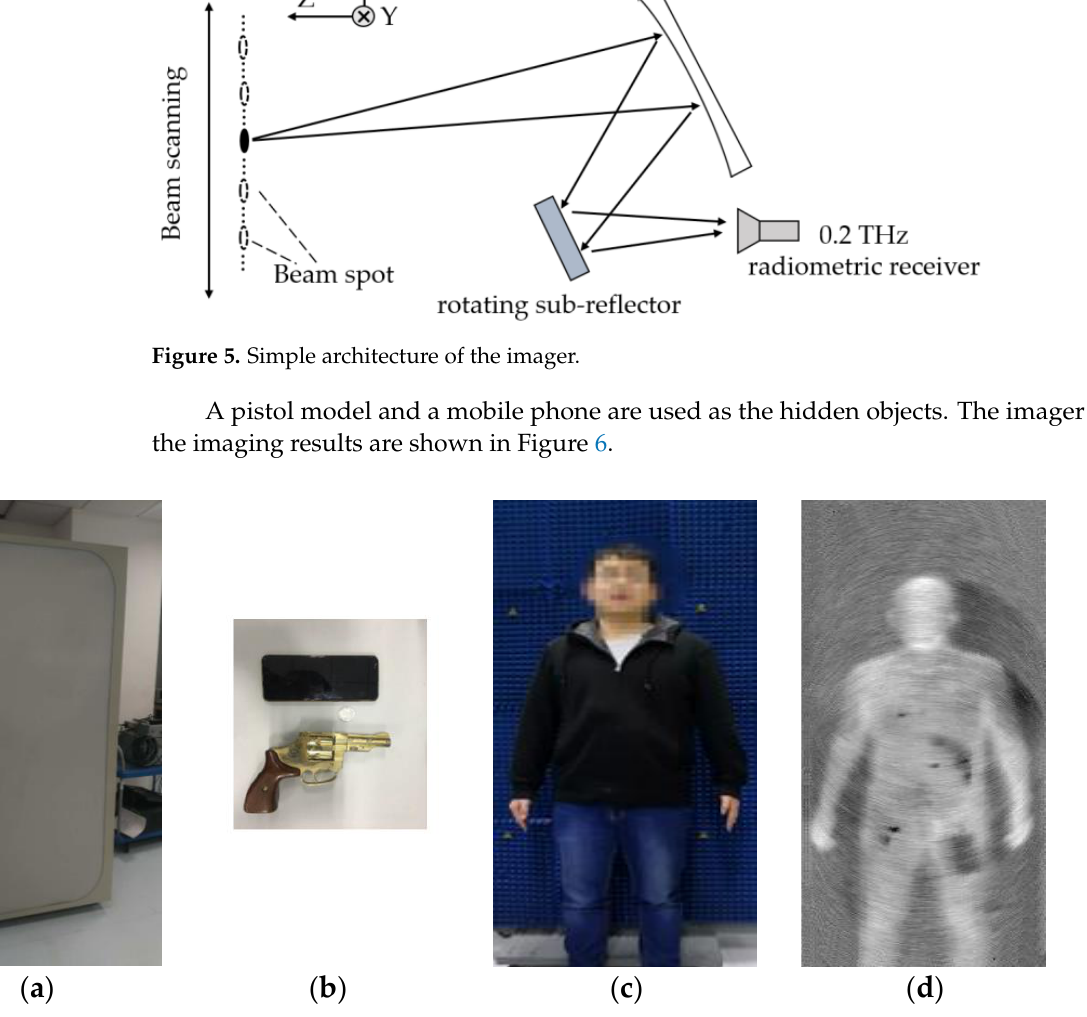
Figure 6. Typical terahertz passive imaging system. ( a ) The passive imaging system. ( b ) Imaging targets. ( c ) The person to be tested. ( d ) Passive imaging results.